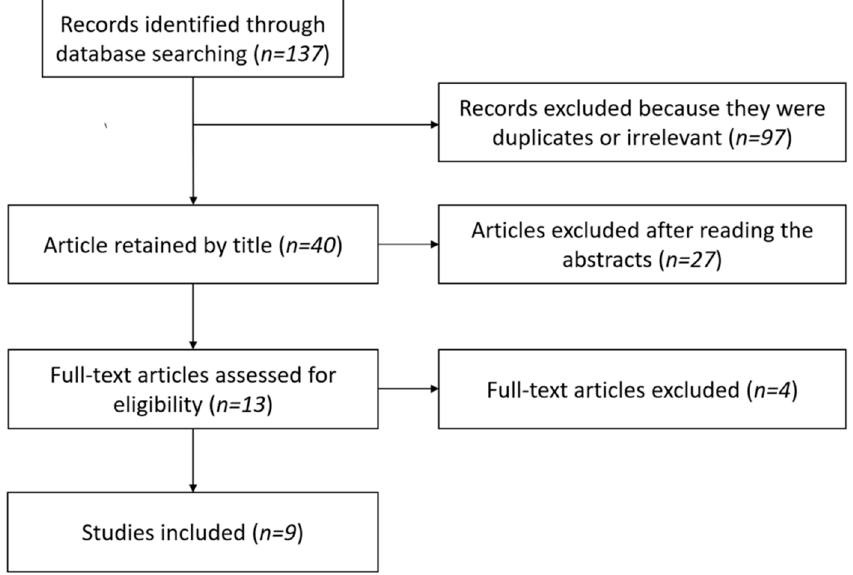
Figure 1. Selection of the studies according to PRISMA guidelines.